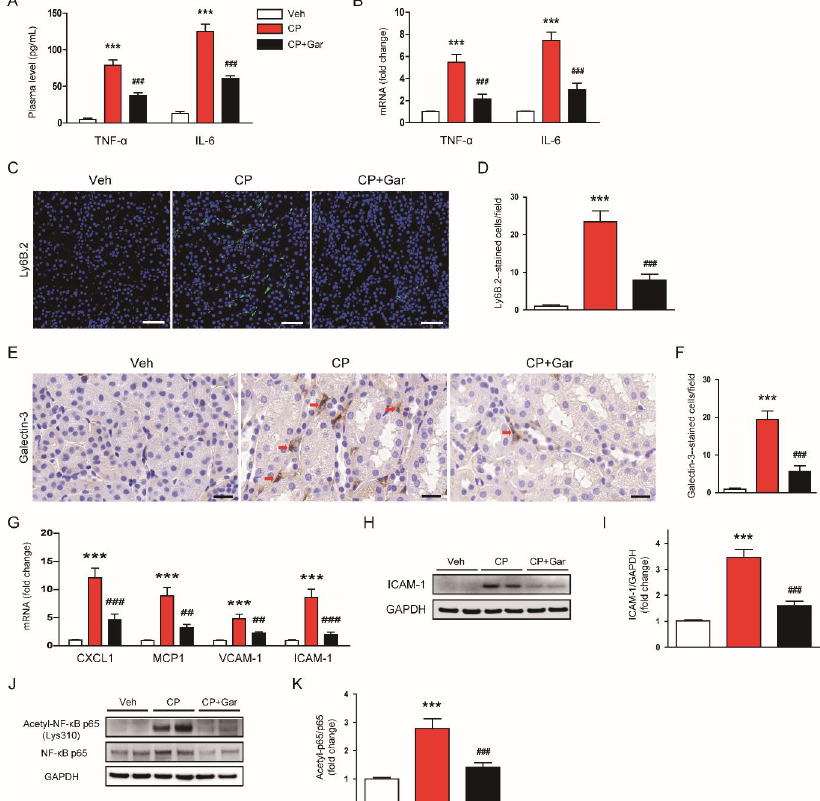
Figure 4. Effect of garcinol on cytokine production, immune cell accumulation, acetylation of nuclear factor- κ B (NF- κ B) p65 in cisplatin-injected mice. ( A ) Plasma levels of tumor necrosis factor- α (TNF- α ) and interleukin-6 (IL-6). ( B ) The mRNA expression of TNF- α and IL-6. ( C ) Immunofluorescent staining of kidney tissues for Ly6B.2. Scale bar = 50 µ m. ( D ) Number of Ly6B.2-stained cells. ( E ) Immunohistochemical staining of kidney tissues for galectin-3. Scale bar = 50 µ m. ( F ) Number of galectin 3-stained cells. ( G ) The mRNA expression of chemokine (C-X-C motif) ligand 1 (CXCL1), monocyte chemoattractant protein-1 (MCP-1), vascular cell adhesion molecule-1 (VCAM-1), and intercellular adhesion molecule-1 (ICAM-1). ( H ) Immunoblotting of ICAM-1. ( I ) Quantification of immunoblot for ICAM-1. ( J ) Immunoblotting of acetyl-NF- κ B p65 (Lys310). ( K ) Quantification of immunoblot for acetyl-NF- κ B p65. n = 8 per group. *** p < 0.001 vs. Veh. ## p < 0.01 and ### p < 0.001 vs.